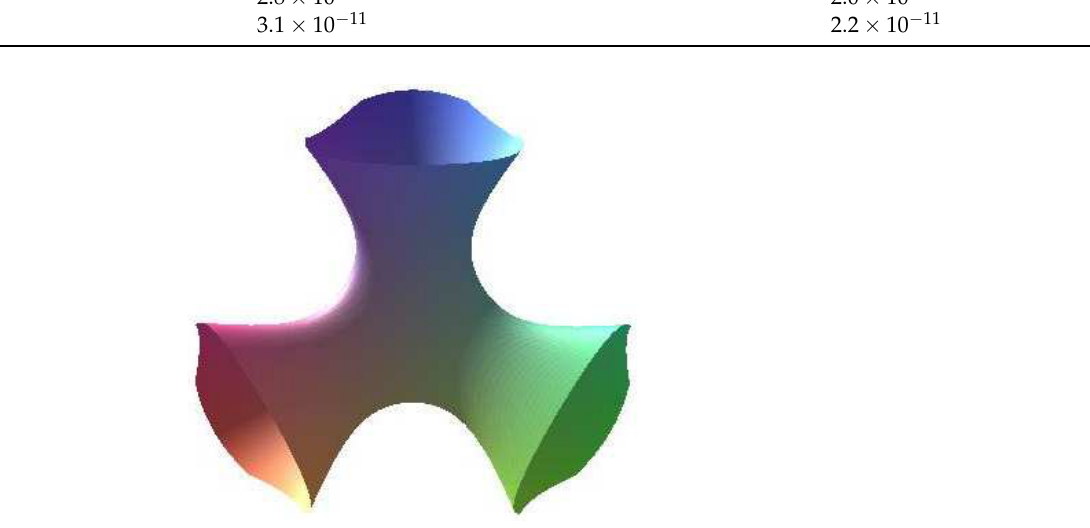
Figure 8. Graphic demonstration for Example